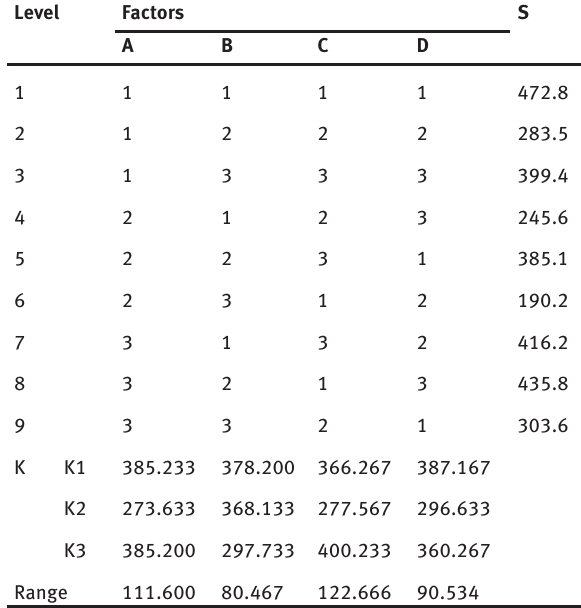
Table 2: Effect of homogeneous pressure on the preparation of GB-LM.